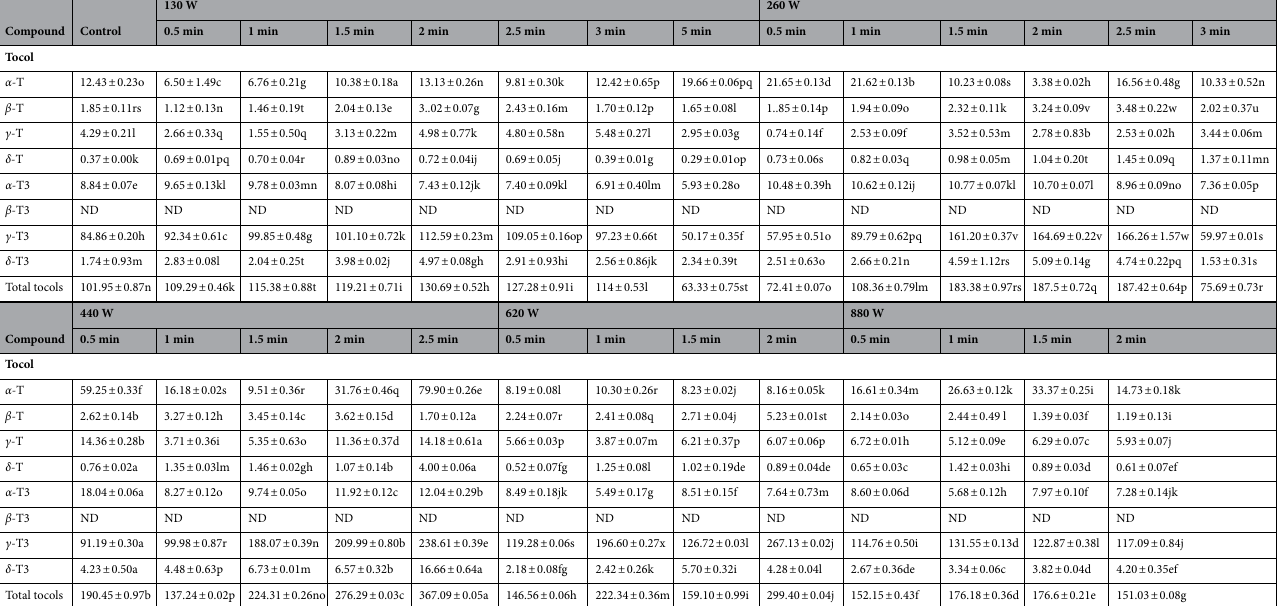
Table 3. Tocols content ( α - , β - , γ - and δ -tocopherol (T) and α - , β - , γ - and δ -tocotrienol (T3)) of rice bran treated in microwave oven (µg/g). ND non detectable. Values are means ± standard deviations ( n =